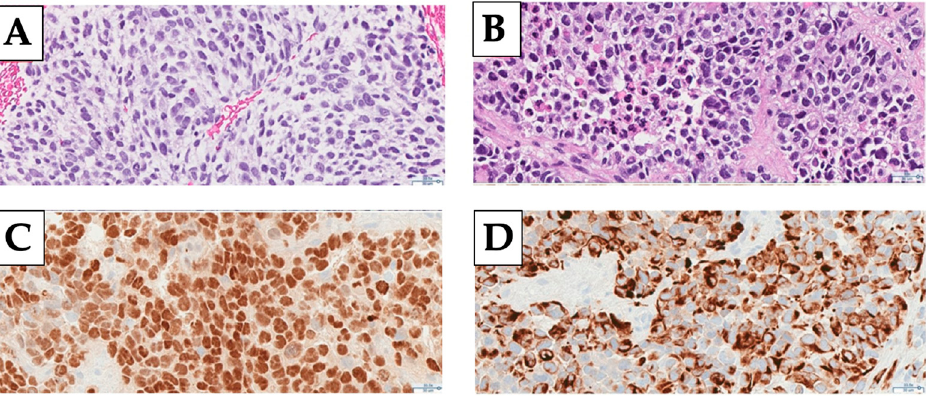
Figure 1. Representative images of the microscopic appearance of rhabdomyosarcoma including hematoxylin and eosin (H&E) staining of embryonal (Panel A ) and alveolar (Panel B ) subtypes and immunohistochemical stains for myogenin (Panel C ) and desmin (Panel D ). Images were obtained at 33.5× magnification.